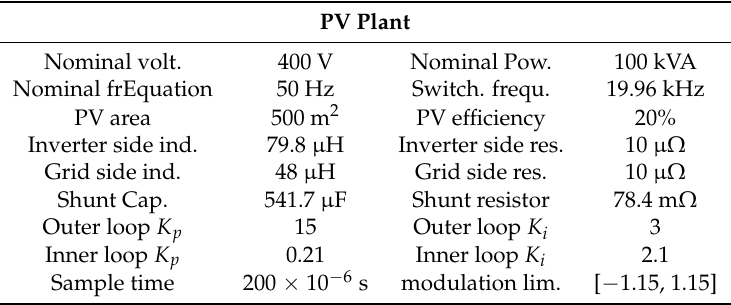
Table 3. Parameters of the photovoltaic (PV)